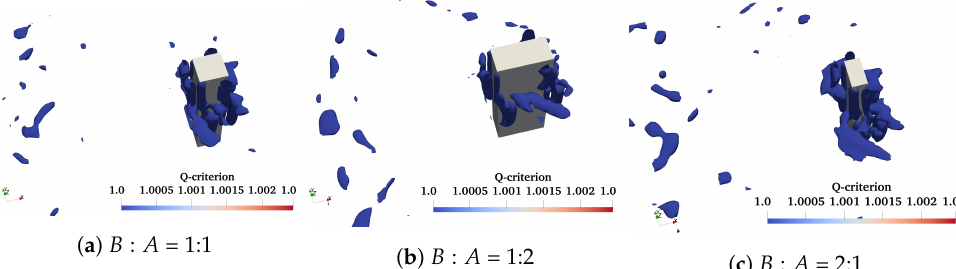
Figure 15. Isosurfaces visualizing turbulent structures for Q = 1 s − 2 , KC number = 3.9, and wave current parameter ( U cw ) = 0.4 for different aspect ratios of the rectangular pile.